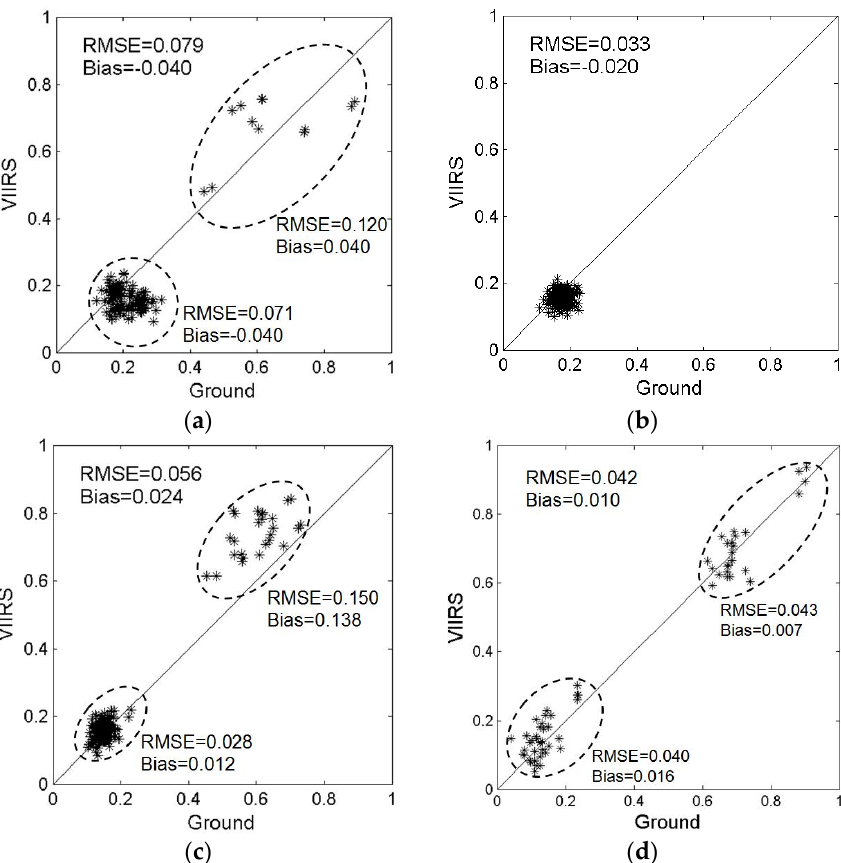
Figure 1. Comparison between VIIRS-retrieved albedo and ground truth over four vegetated sites for the years 2012 and 2013: ( a ) Bondville (Cropland); ( b ) Goodwin Creek (Grassland); ( c ) Table Mountain (Forest); and ( d ) Tiksi (Tundra). Albedo value beyond 0.4 is due to the snow cover on the sites during the winter season. Cloudy observations have been excluded by applying cloud masks.